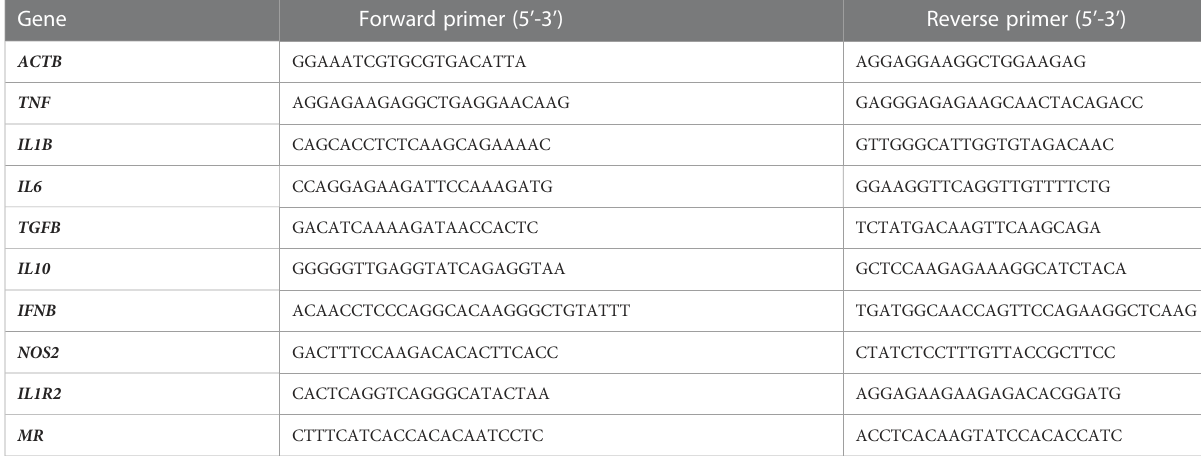
TABLE 2 List of primers used for